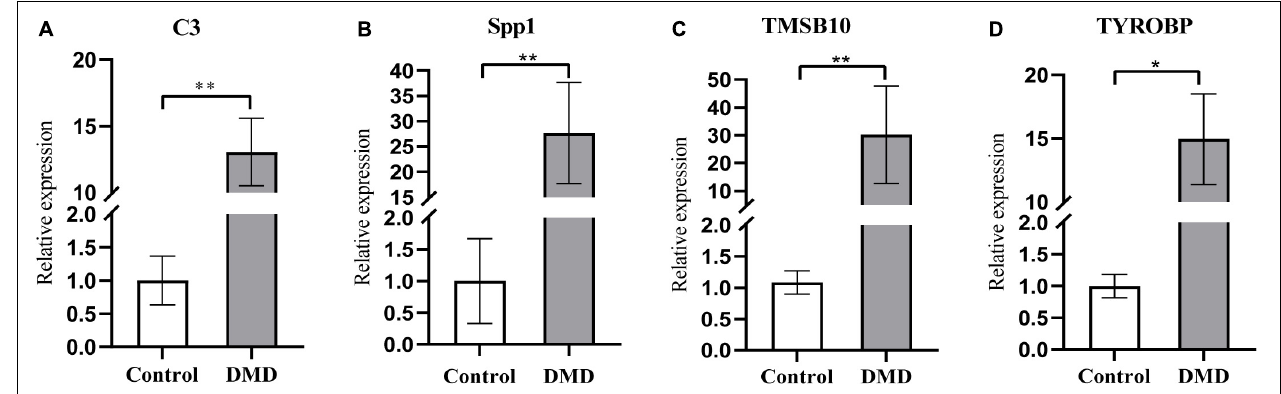
FIGURE 7 | The relative mRNA expression levels of C3 (A) , Spp1 (B) , TMSB10 (C) , and TYROBP (D) in muscle tissues from DMD and control groups, as detected by RT-qPCR with GAPDH as the reference gene. * P < 0.05; ** P <